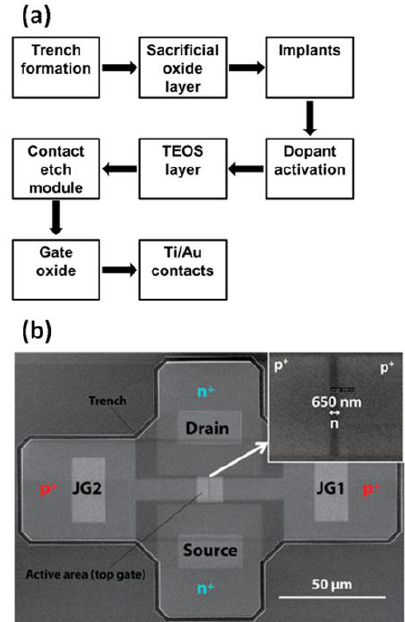
Figure 2. ( a ) Schematic fabrication process flow of an EFN gas sensor; ( b ) scanning electron microscopy image of an EFN device. Note that the critical dimension (650 nm) is the distance between the two metallurgical PN junctions on both sides of the conducting channel. ( b ) is reprinted with permission from [35]. Copyright 2016 American Chemical Society.